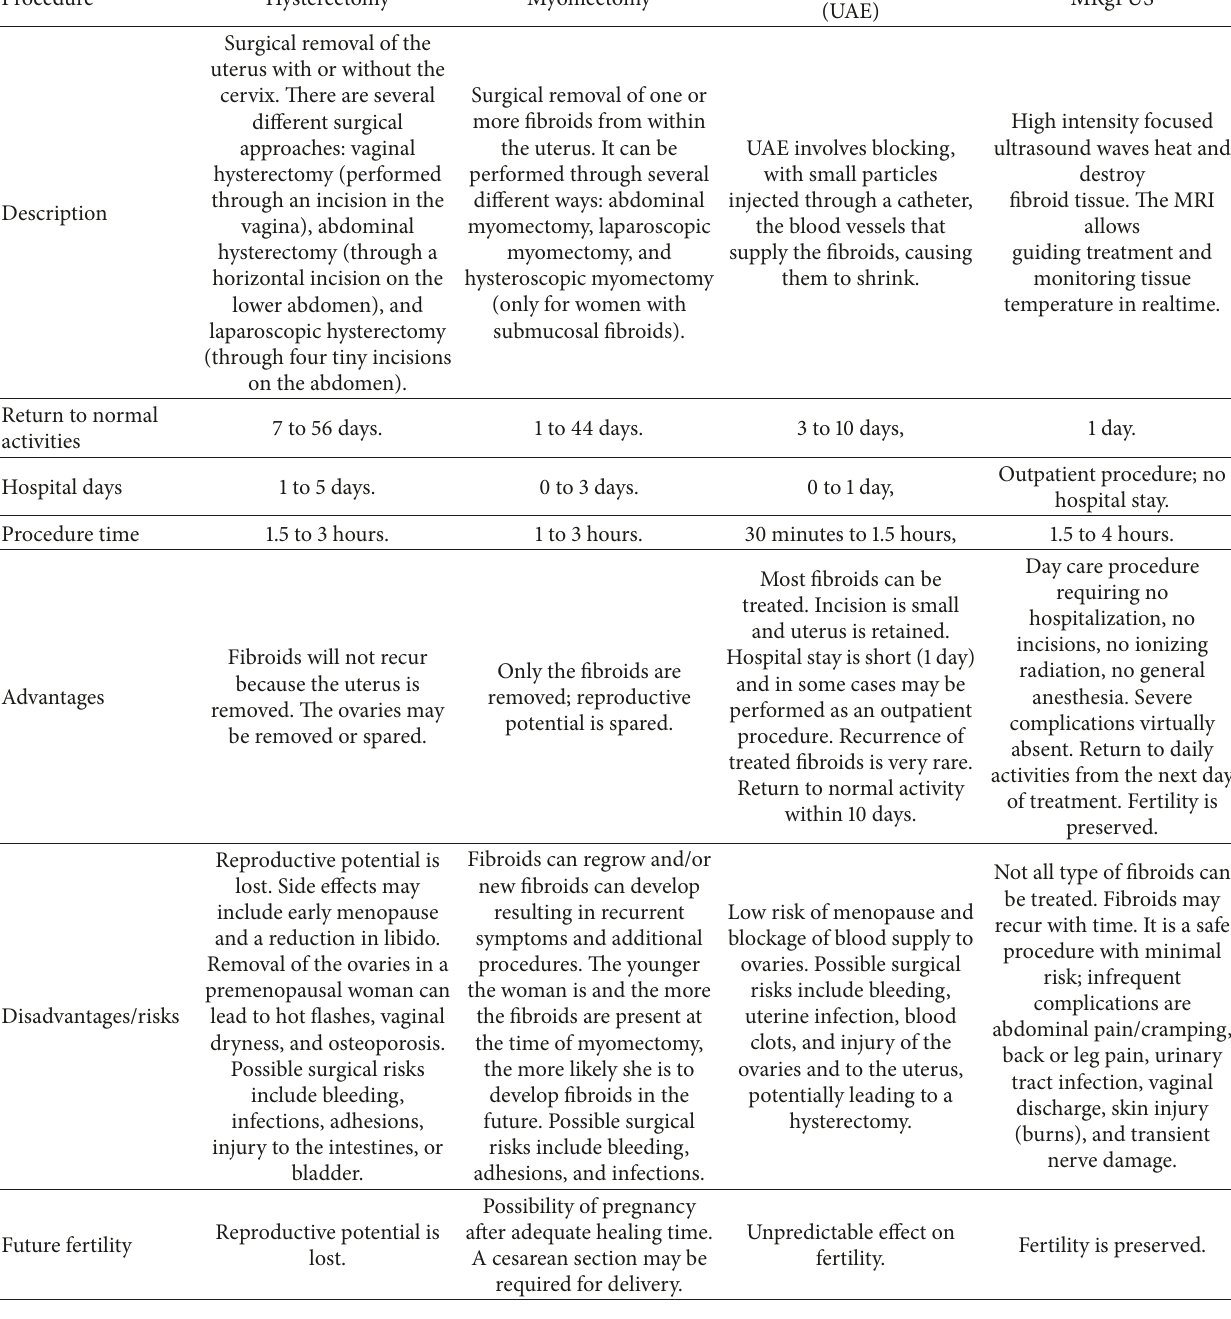
Table 2: Comparison of hysterectomy, myomectomy, uterine artery embolization (UAE), and MRgFUS.